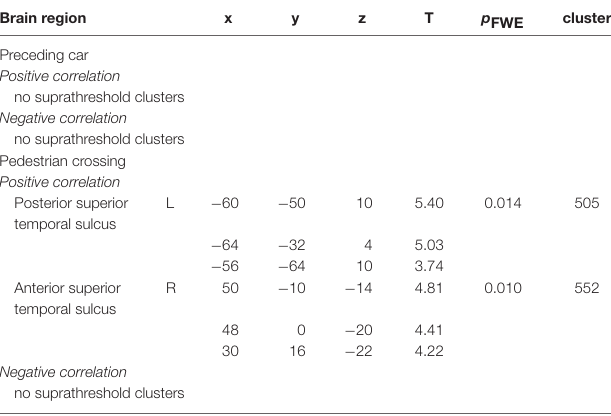
TABLE 4 | Brain regions associated with preceding car braking and pedestrian